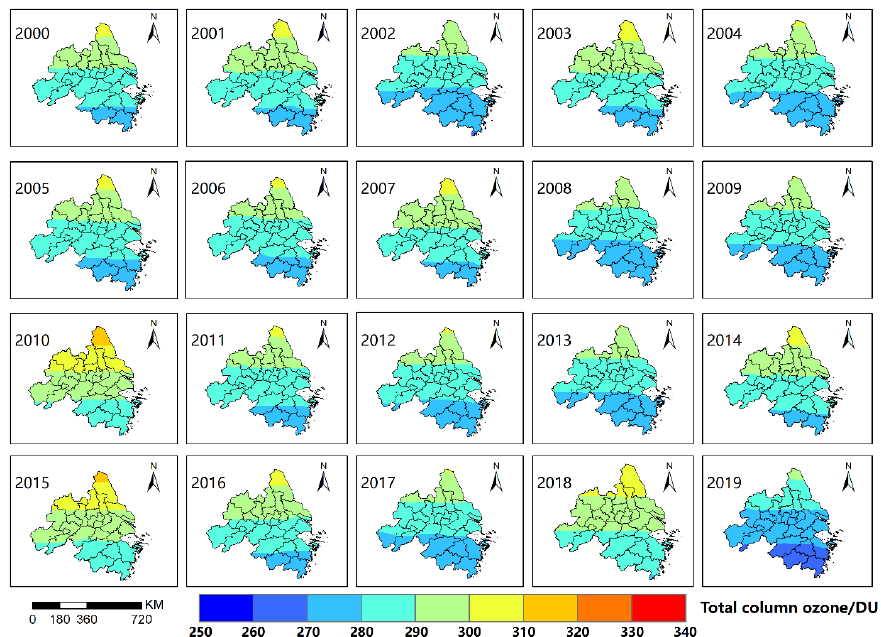
Figure A1. Spatial Distribution of Annual the TCO over the Yangtze River Delta Urban Agglomer- ations during 2000 – 2019. This result is calculated by averaging all monthly TCO in each year over the study area.